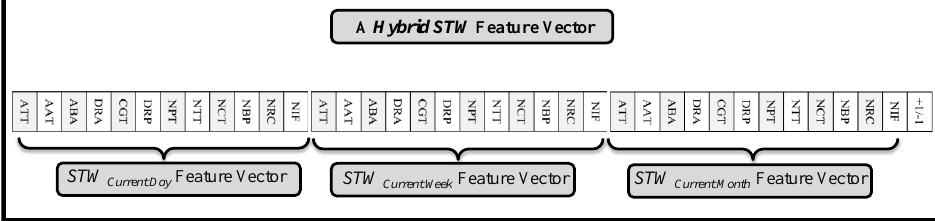
Figure 5. A Sample of a hybrid SSW feature